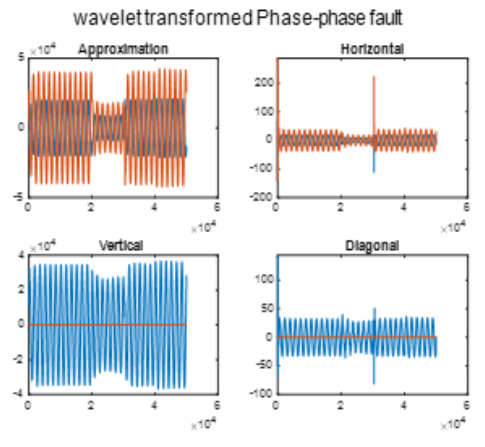
Figure 9. Simulation: wavelet Transform for normal signal